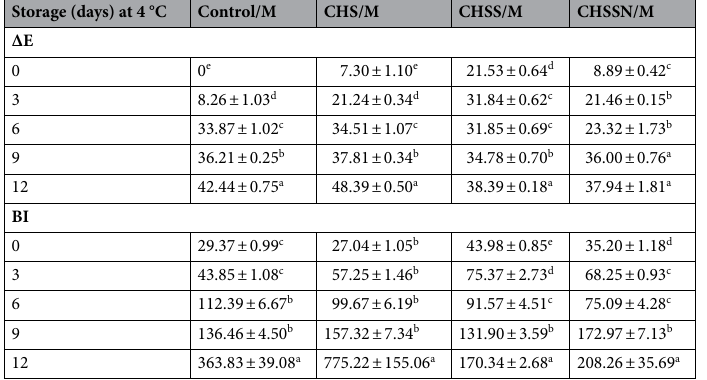
Table 1. Changes of total color variation (ΔE) and browning index (BI). *Results in a column followed by various uppercase letters indicate the significance (p < 0.05) analyzed by the test of Duncan’s multiple-range.